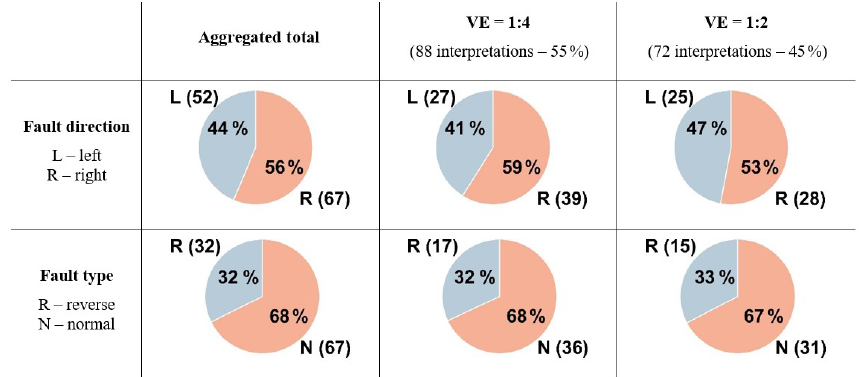
Figure 4. Statistics for the interpreted fault directions (left “L” or right “R”), and motions (normal “N” or reverse “R”) in the sections with 1 : 4 and 1 : 2 vertical exaggeration (“VE”). The number of participants is given in brackets. Note that ambiguous interpretations (e.g. left + right-dipping fault interpretations, or no faults interpreted), corresponding to 41 interpreters (25.6% of the total), were excluded from the count.